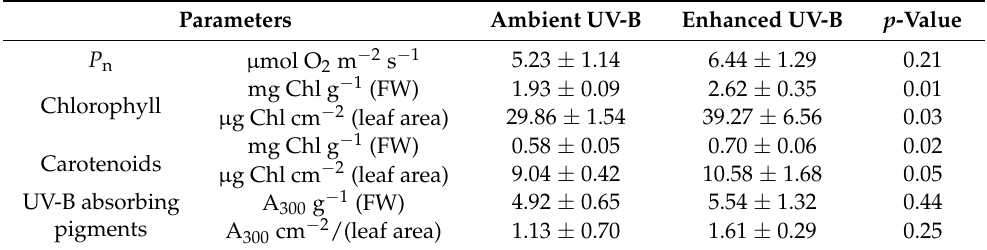
Table 3. Effects of enhanced UV-B on photosynthetic O 2 evolution rate and pigments of K. humilis